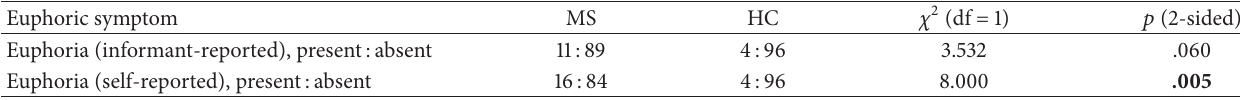
Table 4: Comparison between MS patients and healthy controls of number of participants with contemporary euphoria ( 𝑁 = 200 ). Euphoric symptom